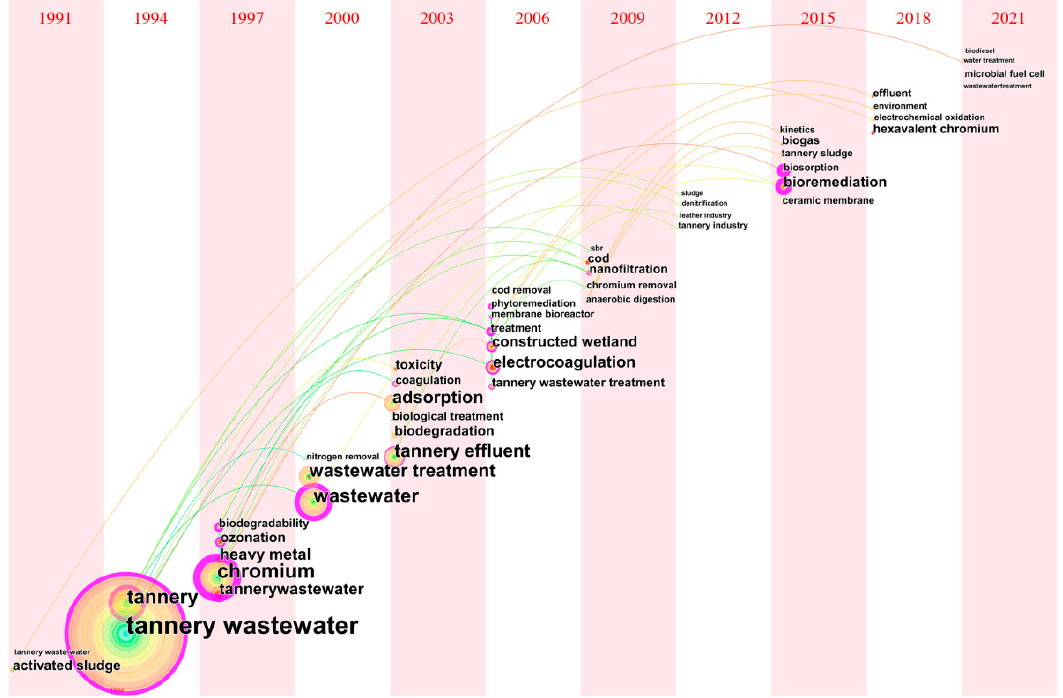
Figure 8. Time-zone view of keywords in tannery wastewater research. It shows that the keyword relationship in the field of tannery wastewater from 1991 to 2022 is quite close, whereas the highest occurrence of keywords is concentrated in the period from 1997 to 2003. Time-zone map is an evolutionary relationship of keywords. Each circle in the figure represents a keyword, and the corresponding year indicates the year that the keyword first appeared in the data analyzed.